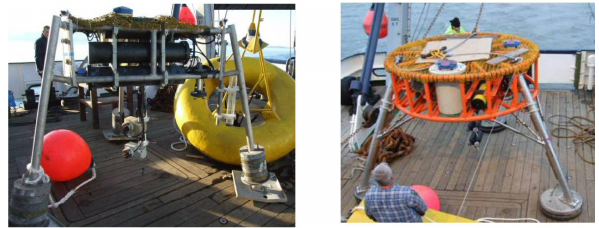
Figure 2. Mini-STABLE (left) and STABLE-III (right) during the deployment manoeuvres on the Prince